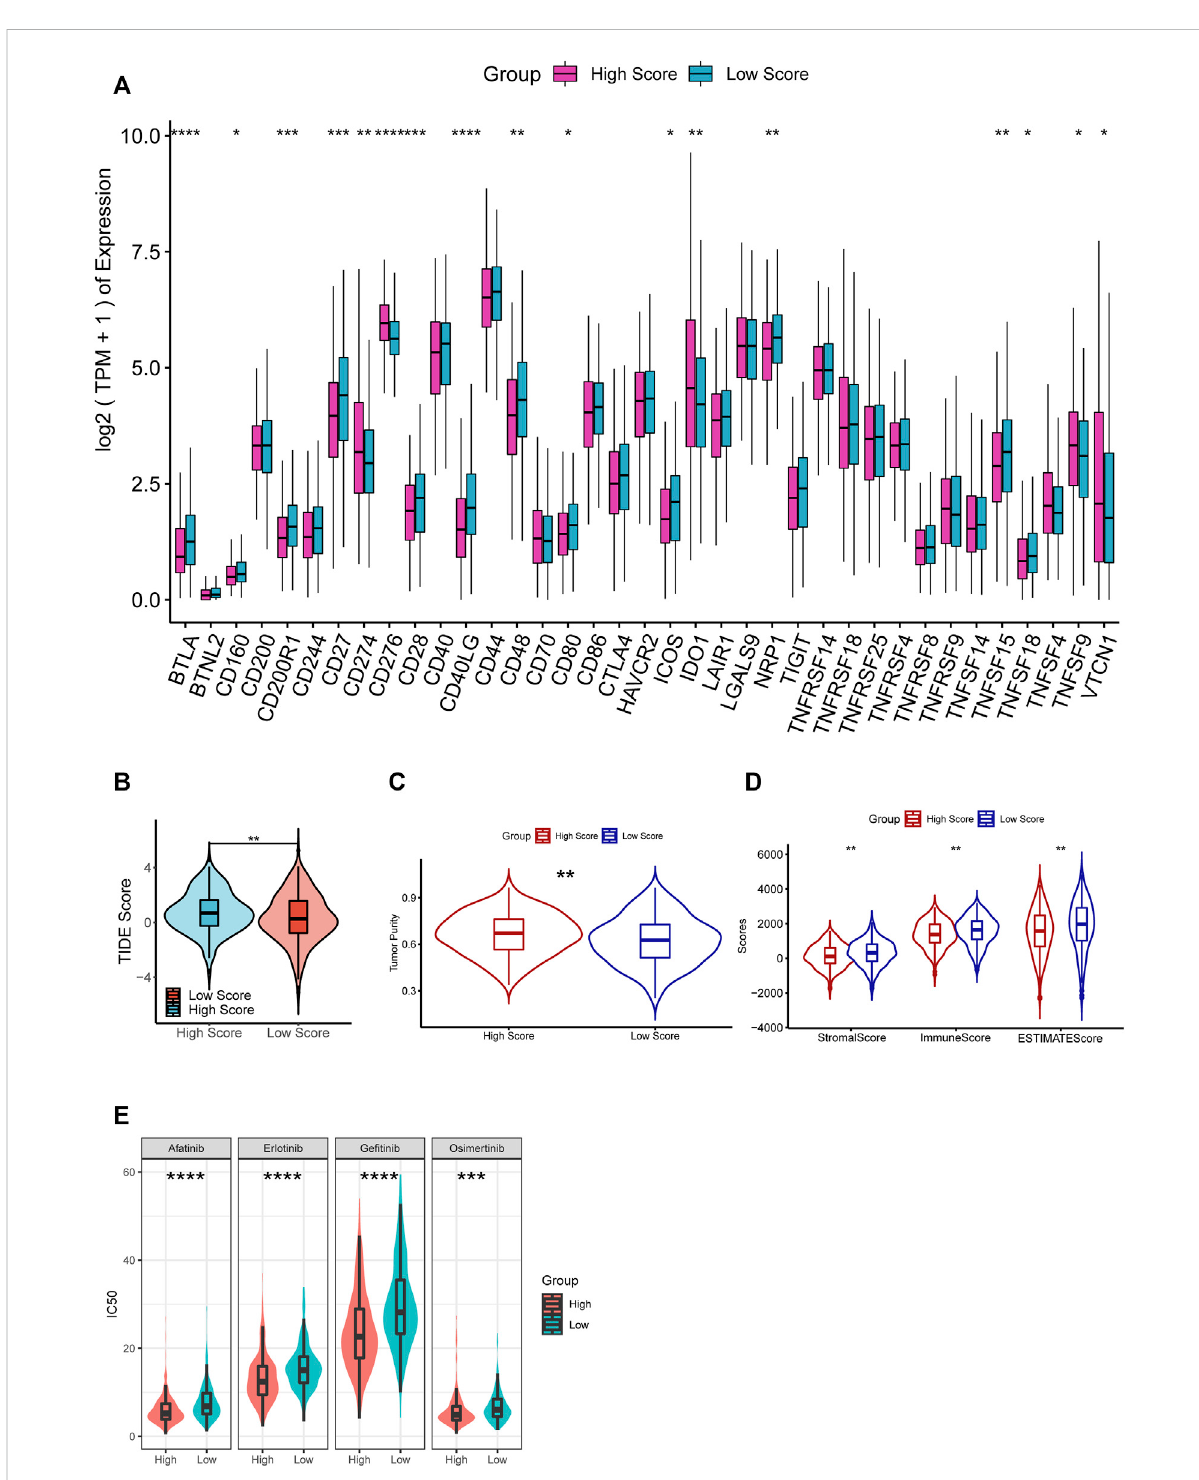
FIGURE 8 (A) Comparisons of the expression of immune checkpoints between high- and low-RS groups. (B – D) Comparisons of TIDE score (B) , tumor purity (C) , stromal score, immune score, and ESTIMATE score (D) between the high- and low-RS groups. (E) Comparisons of the response to drugs between high- and low-RS groups by GDSC